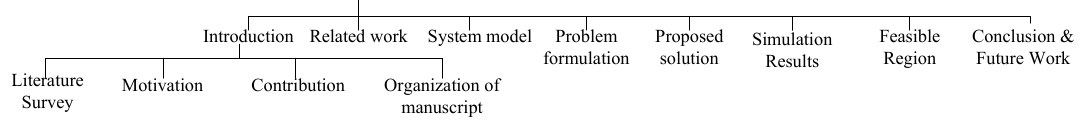
Figure 1. Schematic Manuscript